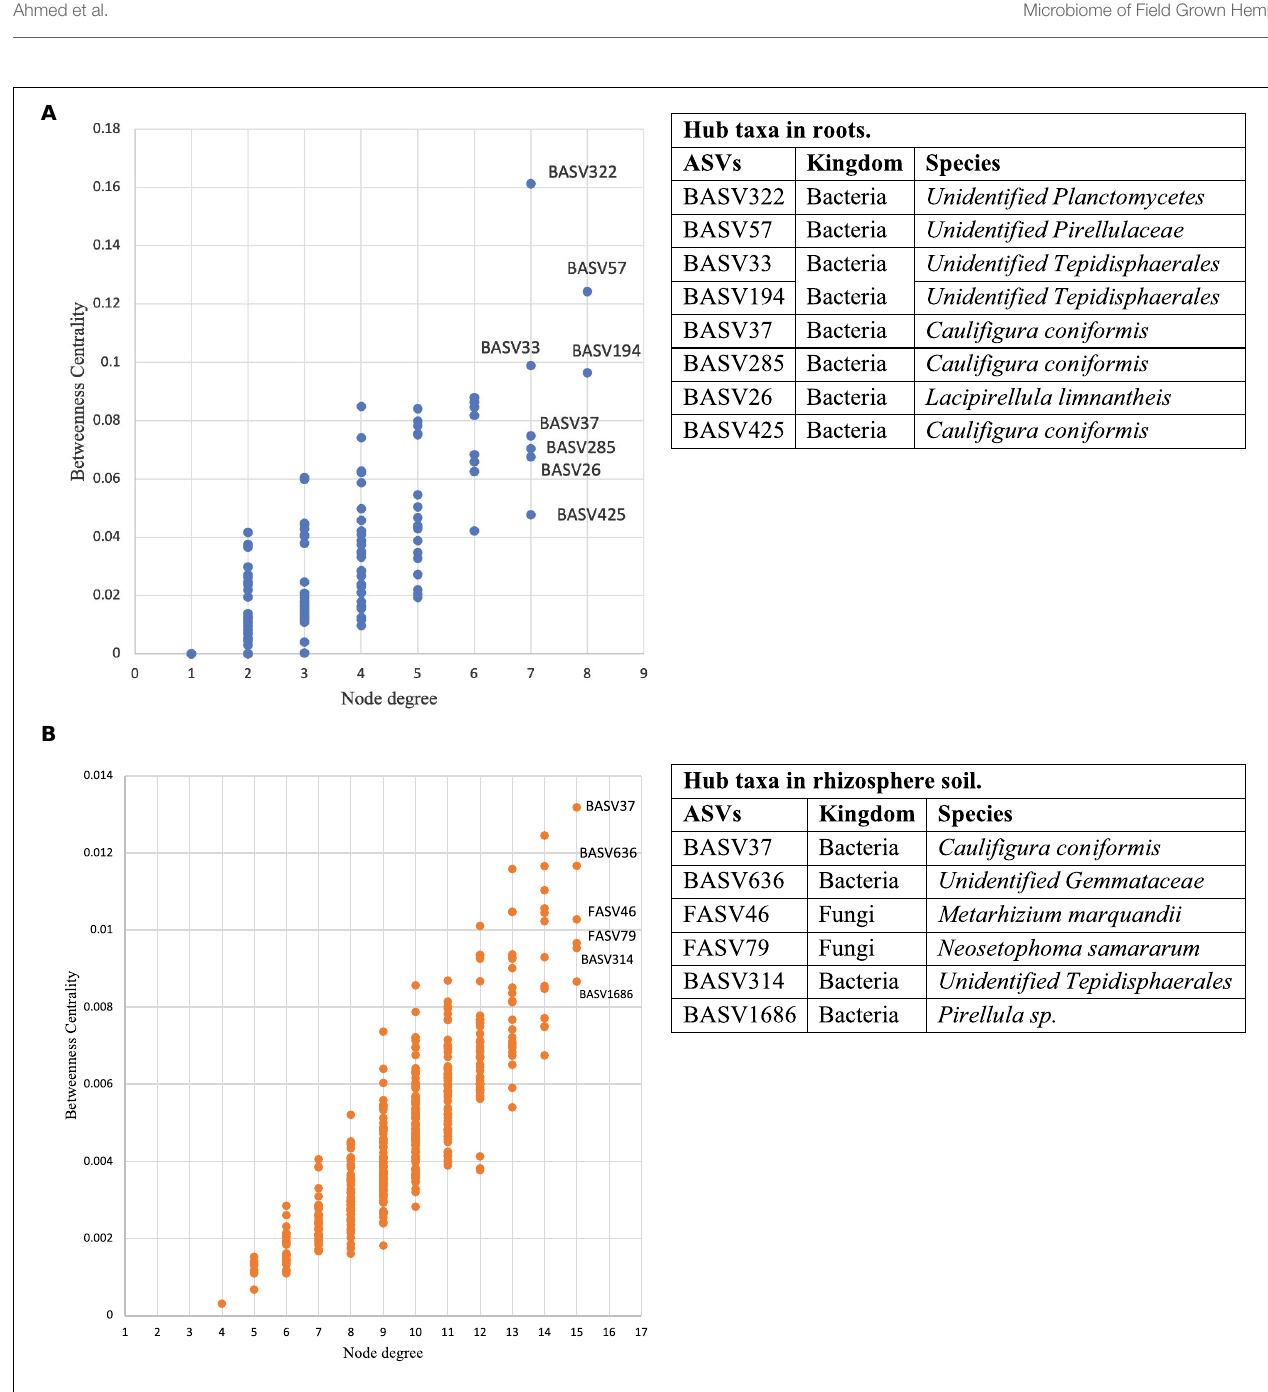
FIGURE 7 | Interkingdom network cooccurrence in hemp microbiome. The microbial network cooccurrence includes three fully independent replicates. Betweenness centrality and node degree of ASVs and their inter-connection identified eight hub taxa in the root (A) . Betweenness centrality and node degree of ASVs and their inter-connection identified six hub taxa in rhizosphere soil (B) . Here soil refers to rhizosphere soil. Tables next to each figure identifies microbiota corresponding to the hub